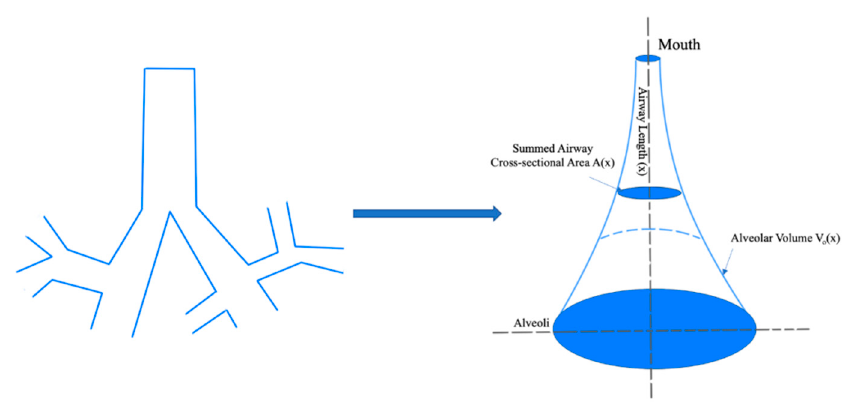
Figure 6. Example of a trumpet-shaped lung model [13].